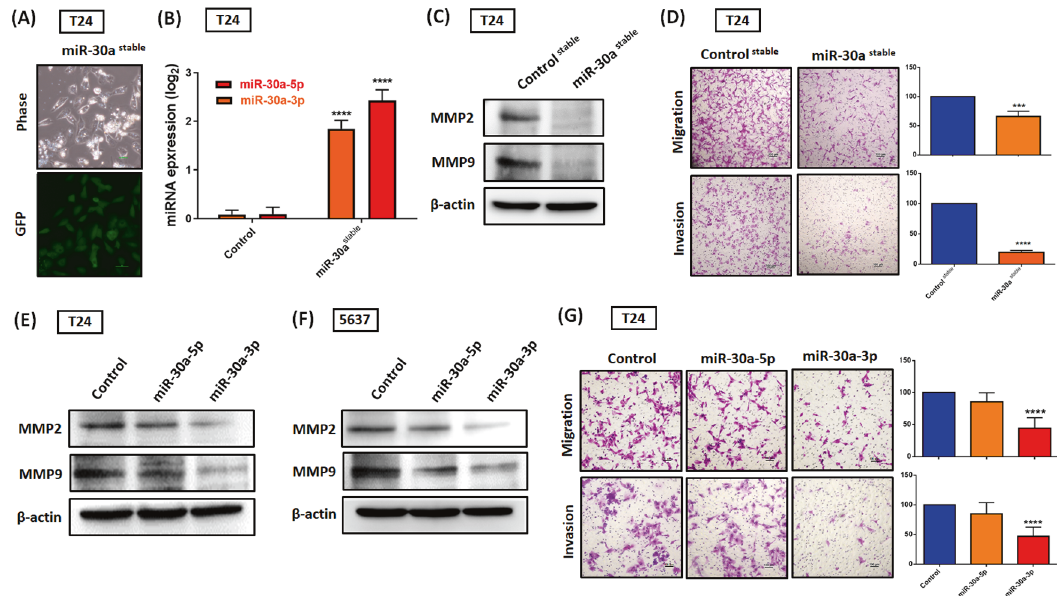
Fig. 2 Hsa-miR-30a-3p reduces MMP2, MMP9 expression and cell invasiveness in BC. A , B Stable cells continuously expressing pri-hsa-miR- 30a were con fi rmed through GFP imaging and hsa-miR-30a-3p or -5p expression ( N = 6). C MMP2 and MMP9 protein expression were evaluated using a western blot assay ( N = 3). D The migration ( N = 5) and invasion abilities ( N = 4) of miR-30a stable cells were measured using Transwell assay. E – G BC cells (T24 and 5637) were transfected with control mimic (25 nM), miR-30a-5p mimic (25 nM), or miR-30a-3p mimic (25 nM) for 24 h; the MMP2 and MMP9 protein expression ( N = 3) and cell migration ( N = 10) and invasion abilities ( N = 7) were analyzed through western blot assay and Transwell assay, respectively. All data are expressed as means ± SDs in triplicate samples. * P < 0.05, ** P < 0.01, *** P < 0.001, and **** P < 0.0001 relative to the control